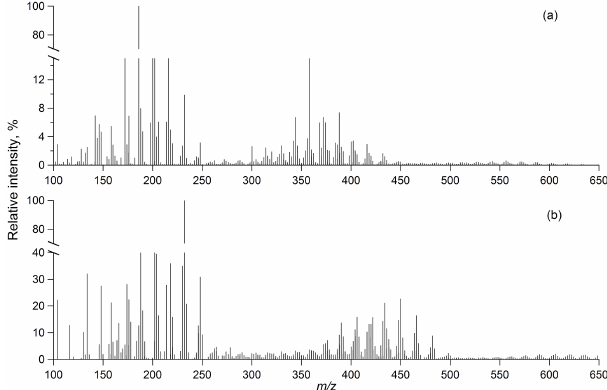
Figure 4. Direct infusion (-) nanoESI-HR mass spectra of the SOA from (a) dark ozonolysis and (b) OH-initiated reaction with α -